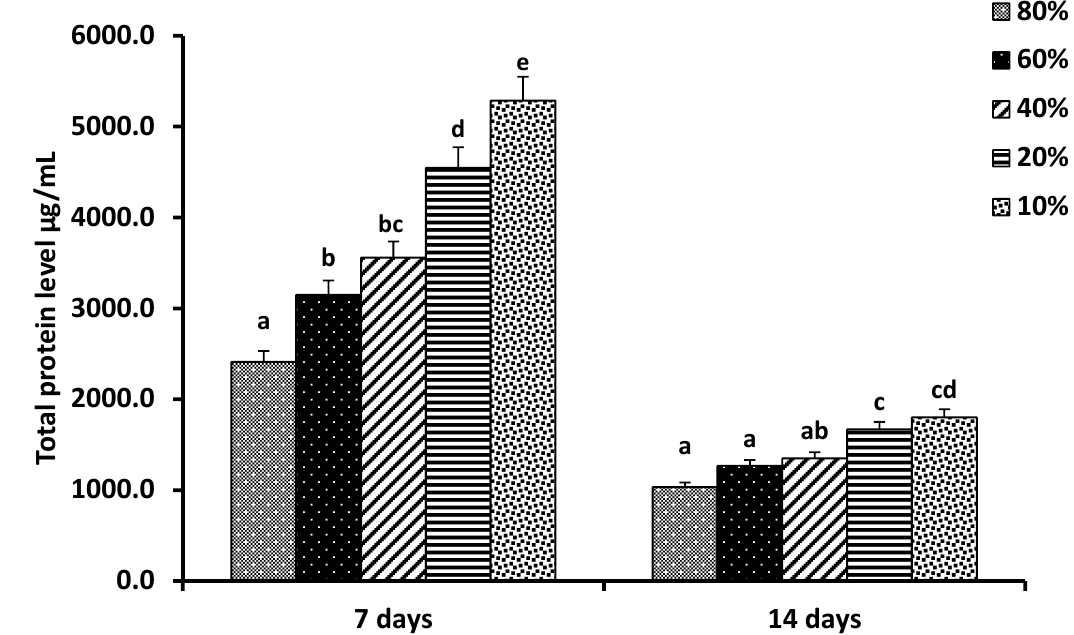
Figure 1. Total protein level of pea ( Pisum sativum L.) seedlings in response to soil water holding capacity levels: 80%, 60%, 40%, 20%, and 10% grown under continuous light at 25 °C for 7 days and 14 days, separately. Protein levels were calculated as µg/mL. Means (columns) with different letter scripts are significantly different ( p ≤ 0.05) by LSD.